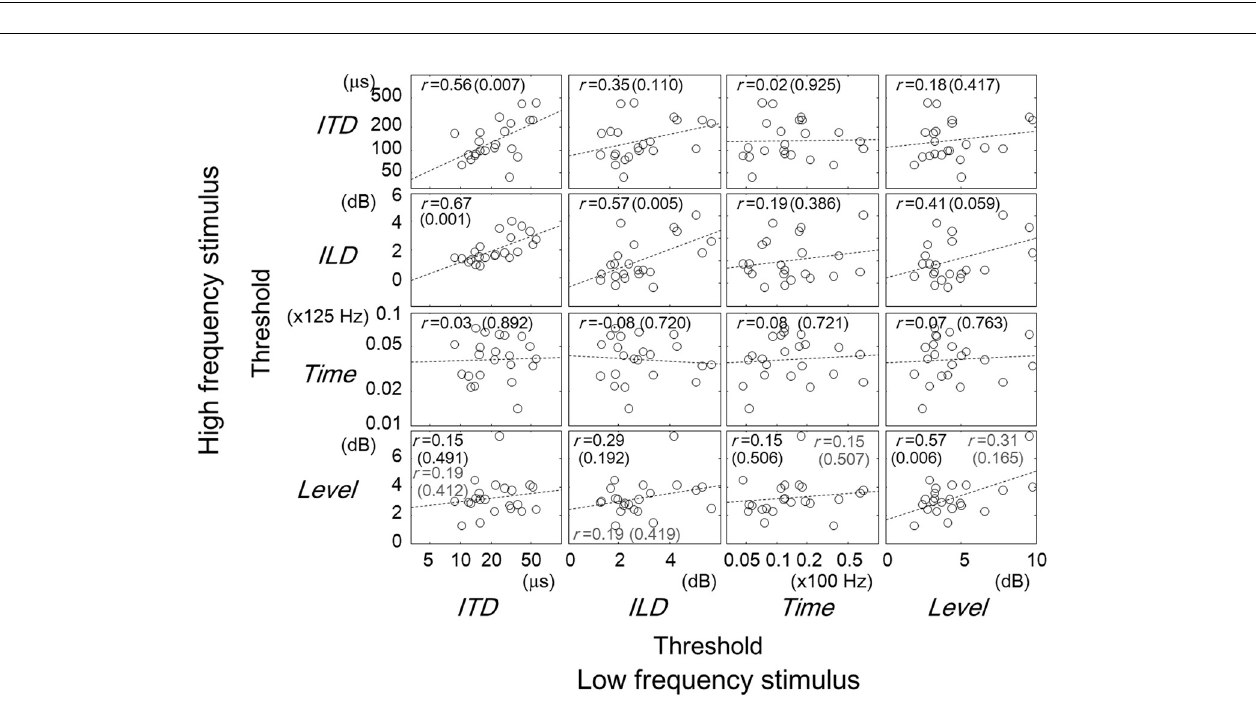
explanatory variable (e.g., for the target of the low-frequency ITD task, the low-frequency ILD task was selected), although the coef- ficients were not always significantly different from zero. It was also confirmed that for target tasks of ITD and ILD tasks, selected explanatory variables included the Time and Level tasks, respec- tively. The partial correlation coefficient for the low-frequency